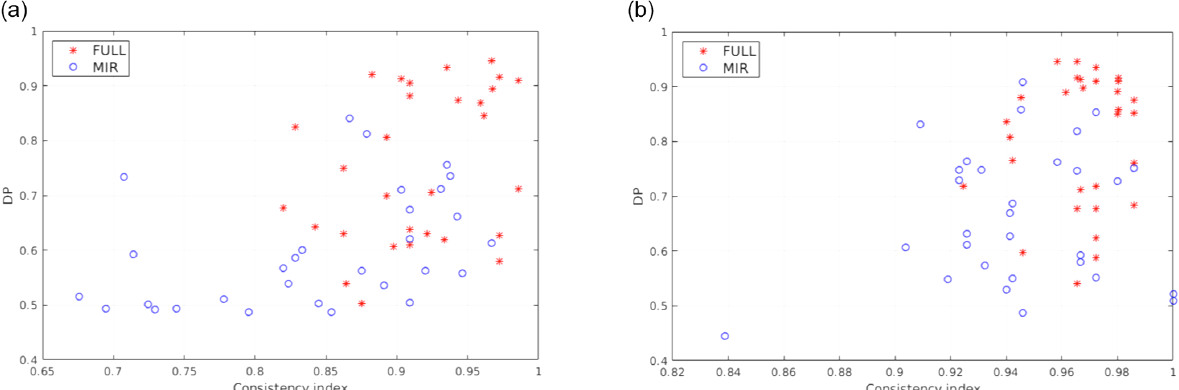
Figure 9. Scatterplots relating the consistency index (CoI) and detection performance (DP) for multiple tropical training set pairs (clear and cloudy). CIC results are shown for both the elementary (a) and the distributional approach (b) . Blue circles represent classification results obtained using features in the MIR only, while red stars represent classification results exploiting the full